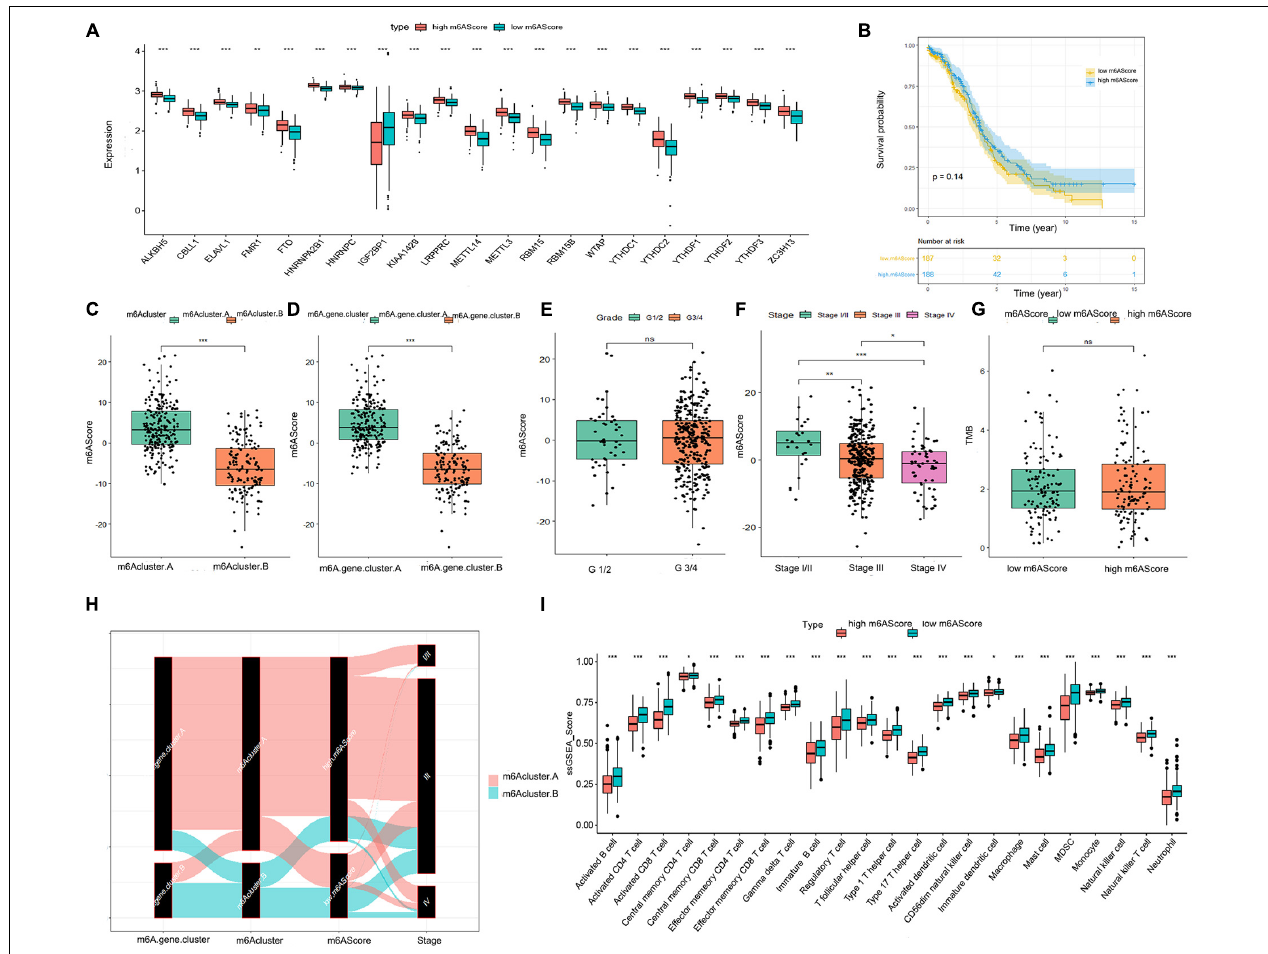
FIGURE 4 | Significance of the m6A score in ovarian cancer. (A) Differential expression boxplot of the 21 m6A regulators in high and low m6A scores. (B) Kaplan-Meier curves showing the prognostic value of the m6A score in TCGA-OV dataset. Differences in m6A score between m6Acluster.A and m6Acluster.B (C) and m6A.gene.cluster.A and m6A.gene.cluster.B (D) . (E) Differences in m6A score between tumor grade (G)1/2 and G3/4. (F) Differences in m6A score between different stages of ovarian cancer. (G) Differences in the TMB level between high and low m6A scores. (H) Sankey diagram revealing the relationship